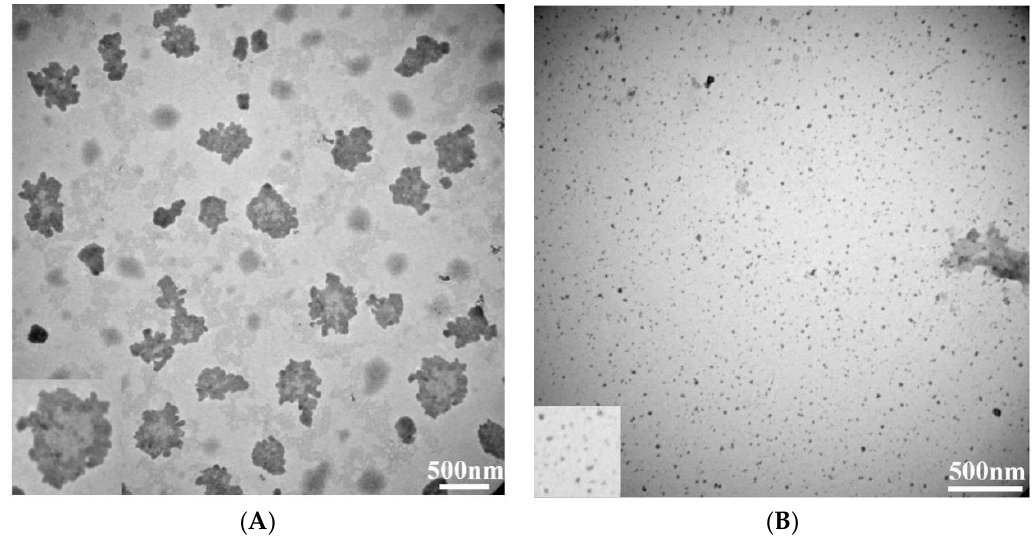
Figure 2. Transmission electron microscopy (TEM) images of the fabricated AHAna aggregates ( A ) and HAn nanoparticles ( B ).